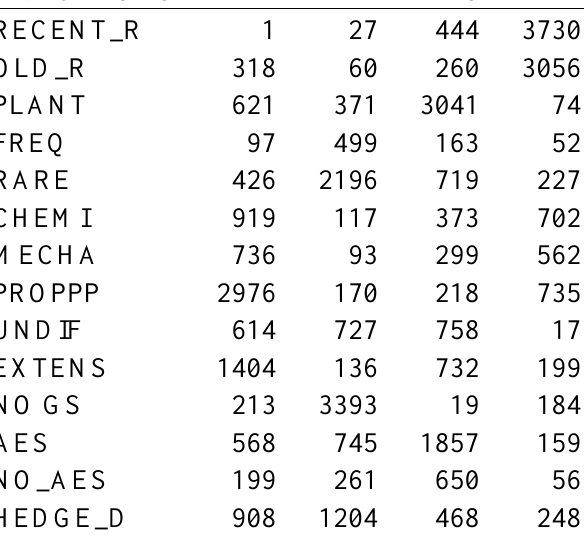
Table A1.2 Contribution of the indicators used for Typology 2 on the 4 axes (see Table 1 in the main text for the meaning of indicators’